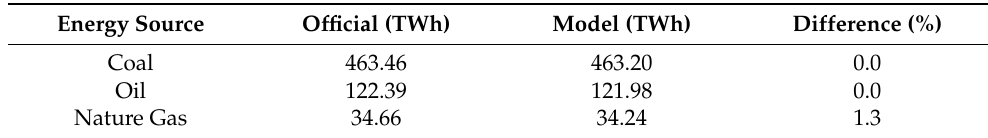
Table 3. Comparison of fossil energy consumption between the official values and the simulation results.